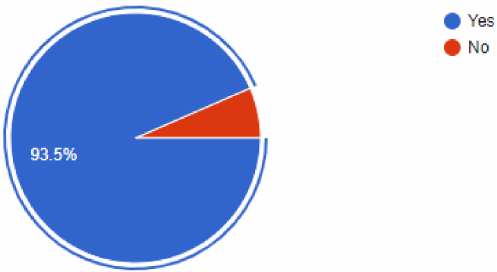
Figure 15. Will you continue to employ these measures once you and your staff are